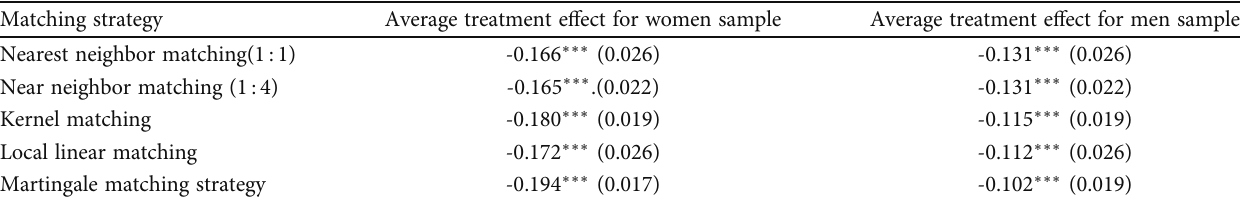
Table 6: In fl uence of Internet usage on gender division of labour bias held by di ff erent genders. Matching strategy Average treatment e ff ect for women